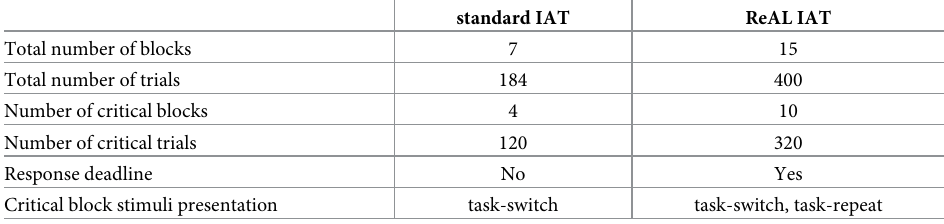
Table 1. Details of the standard and ReAL IAT